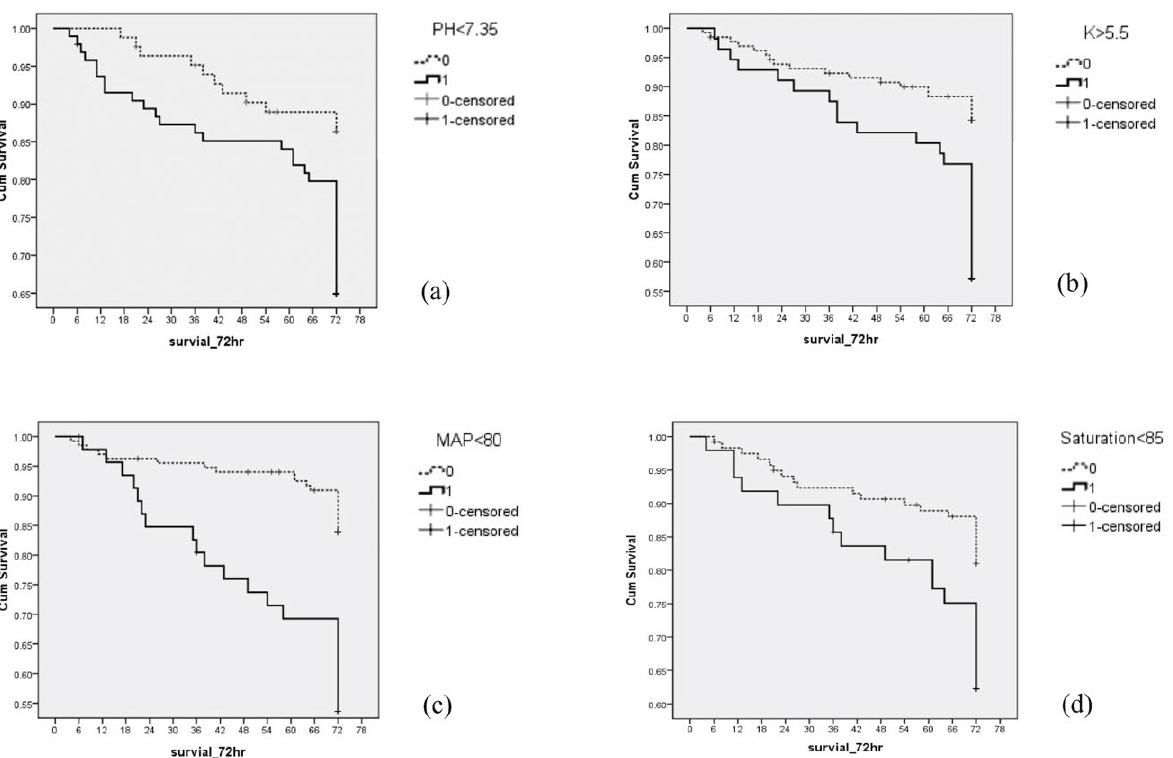
Figure 3. Survival analysis of the Kaplan-Meier curve and Log Rank test within the survival of IHCA from significant variables in each domain. ( a ) Survival curve differentiation of pH < 7.35 with Log Rank (Mantel-Cox) = 0.002. ( b ) Survival curve differentiation of potassium > 5.5 mmol/L with Log Rank (Mantel-Cox) < 0.001. ( c ) Survival curve differentiation of mean arterial pressure < 80 mmHg with Log Rank (Mantel-Cox) < 0.001. ( d ) Survival curve differentiation of pulse oximetry saturation < 85% with Log Rank (Mantel-Cox) = 0.01. Table 4. Establishment of the scoring system after rounding and dividing β coefficients from the final model from signif- icant variables in each domain.